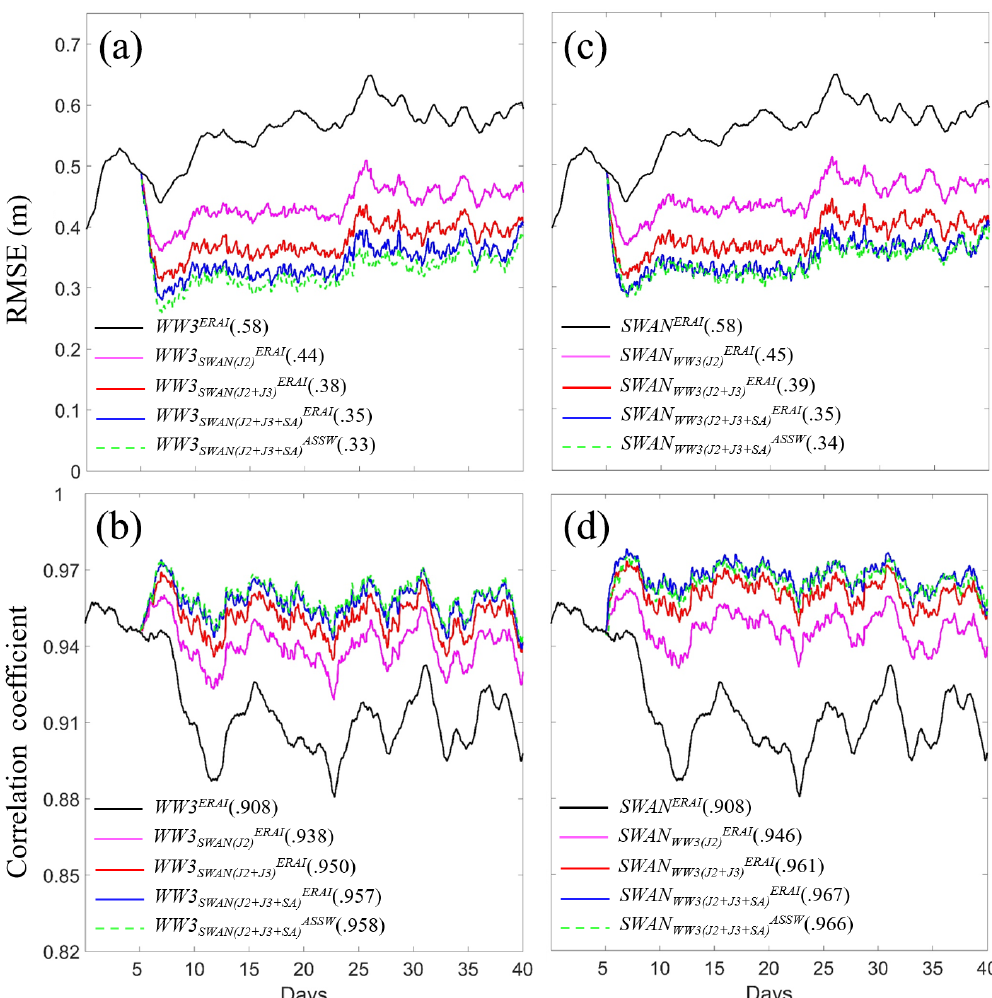
Figure 4. The time series of RMSEs (a, c) and spatial correlation coefficients (b, d) of the WW3 (a, b) and SWAN (c, d) biased model experiments in the model control run forced by the ERA-Interim wind (black, denoted as WW3 ERAI and SWAN ERAI ), assimila- and tions with “observed” data from one (pink, denoted as WW3 ERAI and SWAN ERAI ), two (red, denoted as WW3 ERAI SWAN(J2) WW3(J2) SWAN ( J2 + J3 ) SWAN ERAI ) and three (blue, denoted as WW3 ERAI and SWAN ERAI ) satellites, as well as the assimilation WW3 ( J2 + J3 ) SWAN ( J2 + J3 + SA ) WW3 ( J2 + J3 + SA ) with corrected wind (dotted green, denoted as WW3 ASSW and SWAN ASSW ) against the truth (same as in Fig. 3 but SWAN ( J2 + J3 + SA ) WW3 ( J2 + J3 + SA ) for SWAN and WW3 with the ERA-Interim wind). The numbers in the parentheses correspond to the globally averaged RMSE (in a and c ) and spatial correlation coefficient (in b and d ) over the last 30d during the assimilation period. The observed data are produced by projecting the truth SWH onto the satellite